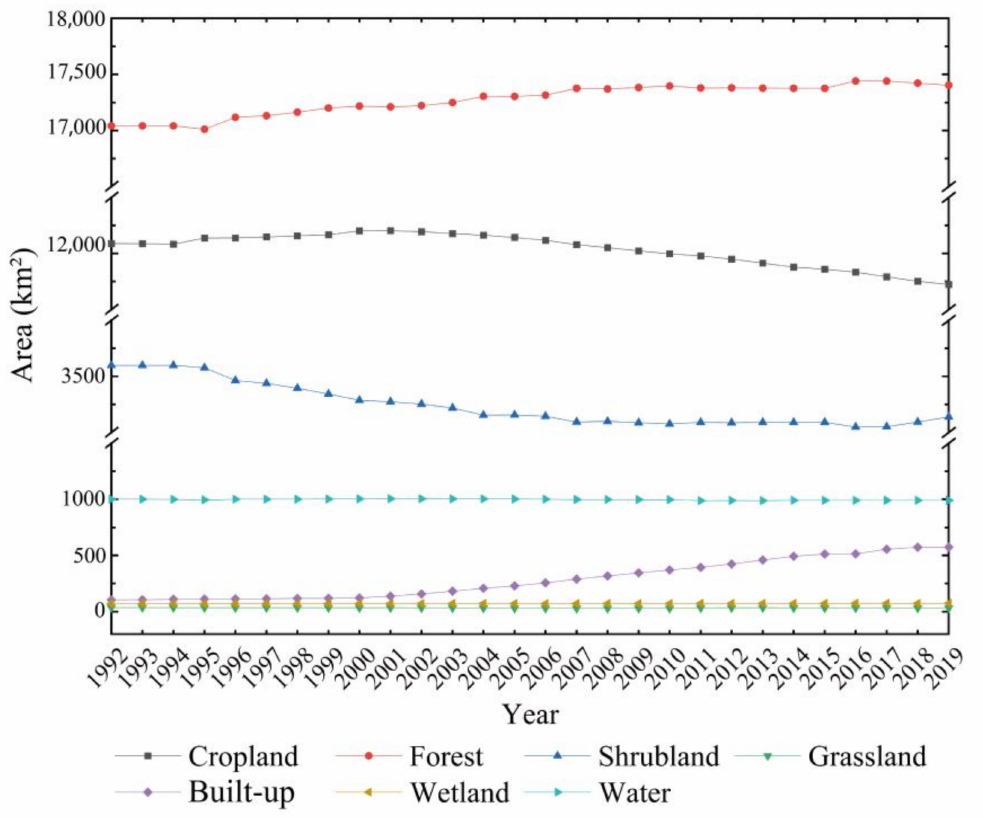
Figure 4. LULC dynamics of Hainan Island from 1992 to